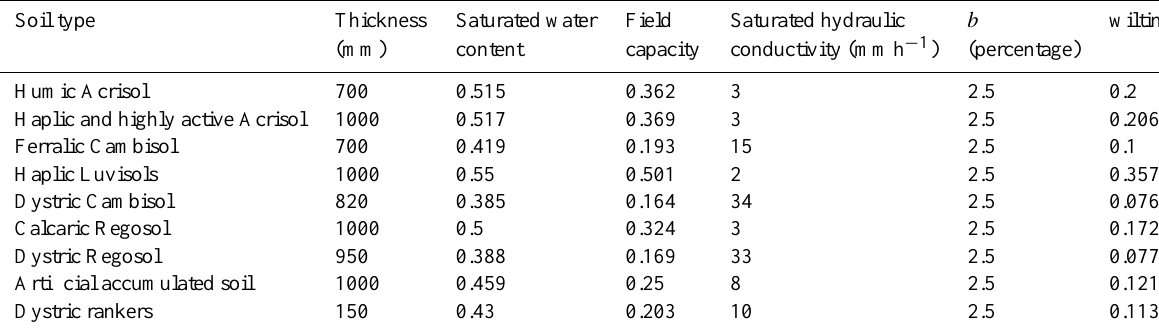
Table 3. Initial values of soil-based parameters in Tiantoushui catchment. Soil